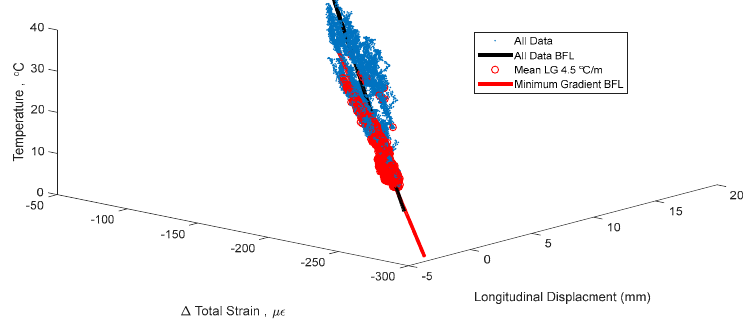
Figure 13. 3D signature with best fit line (BFL) for time points with minimal thermal gradient, identified using (Mean Local Gradient) MeLG method.